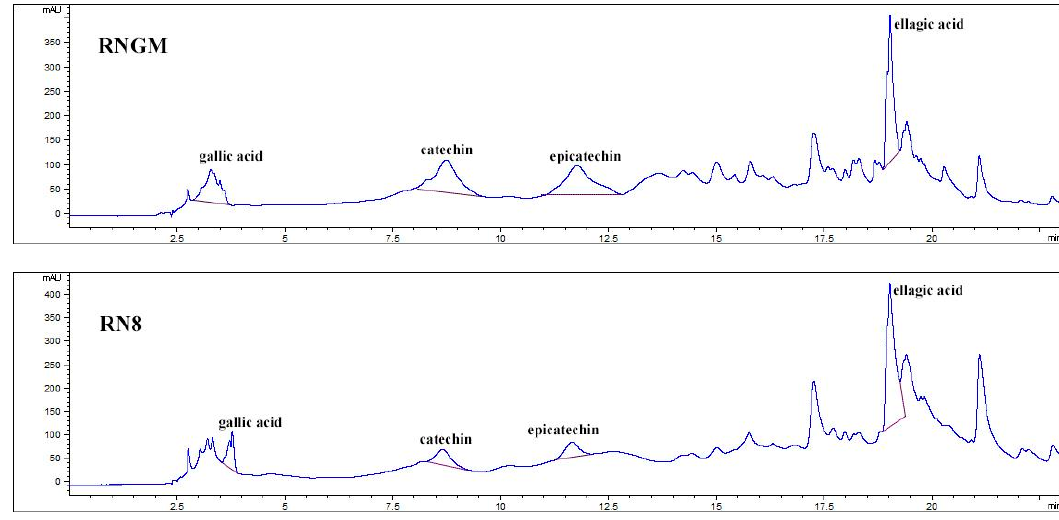
Figure 5. Chromatographic pattern of polyphenolic compounds identified in RN8 and RNGM samples: ( A ) Cinnamic acids and flavonols; ( B ) Benzoic acids and catechins. In the chromatograms, the x-axis represents the signal current intensity (mAU), while the y-axis represents time (minutes).